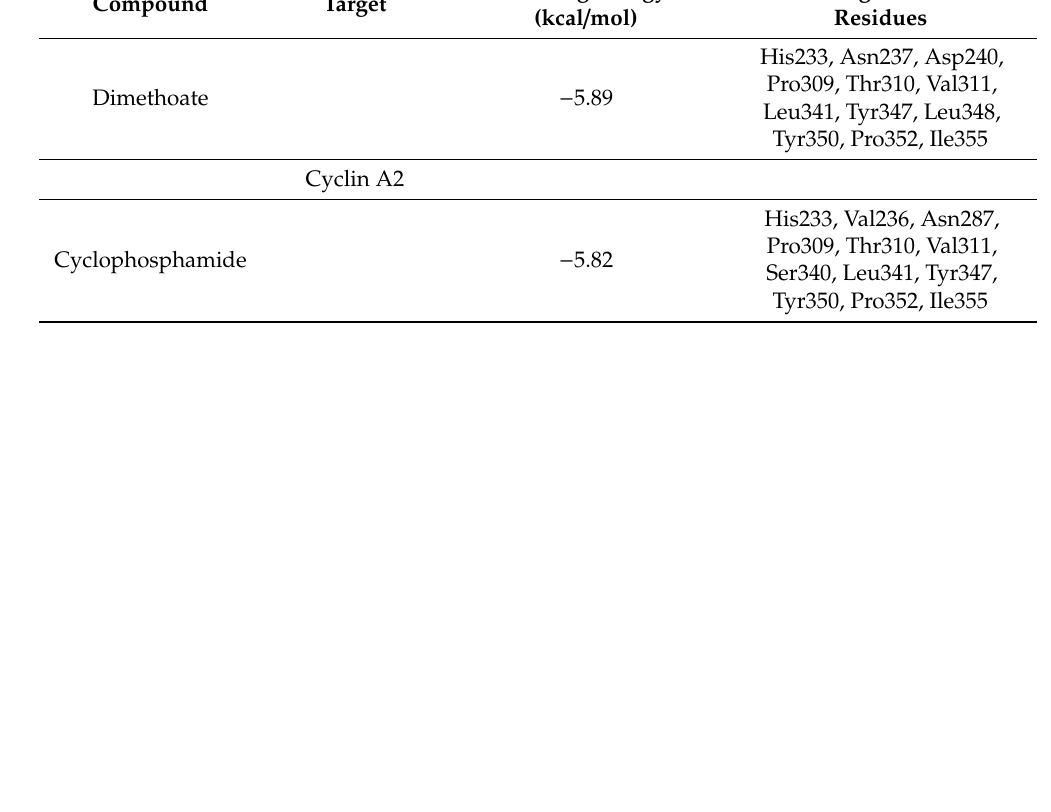
Figure 5. Molecular docking showed strong hydrophobic interaction and hydrogen bonding in “DM-Cyclin A2” ( a ) Interaction of Dimethoate with cyclin A2. The ligand (Dimethoate) has been shown in “stick” representation. ( b ) “Ligplot” of Figure 5a showing bonding interactions. Table 5. Amino acid residues of Cyclin A2 involved in respective ligand interactions. Binding Compound Target